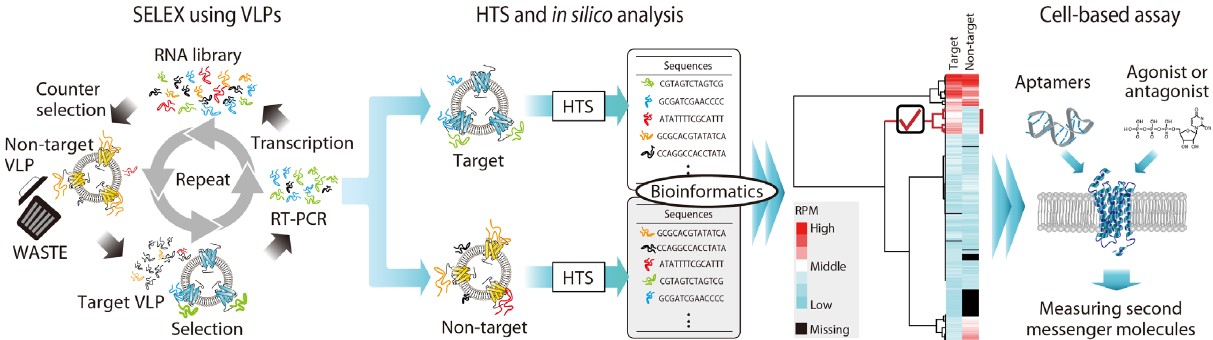
material for unstable cell surface proteins such as